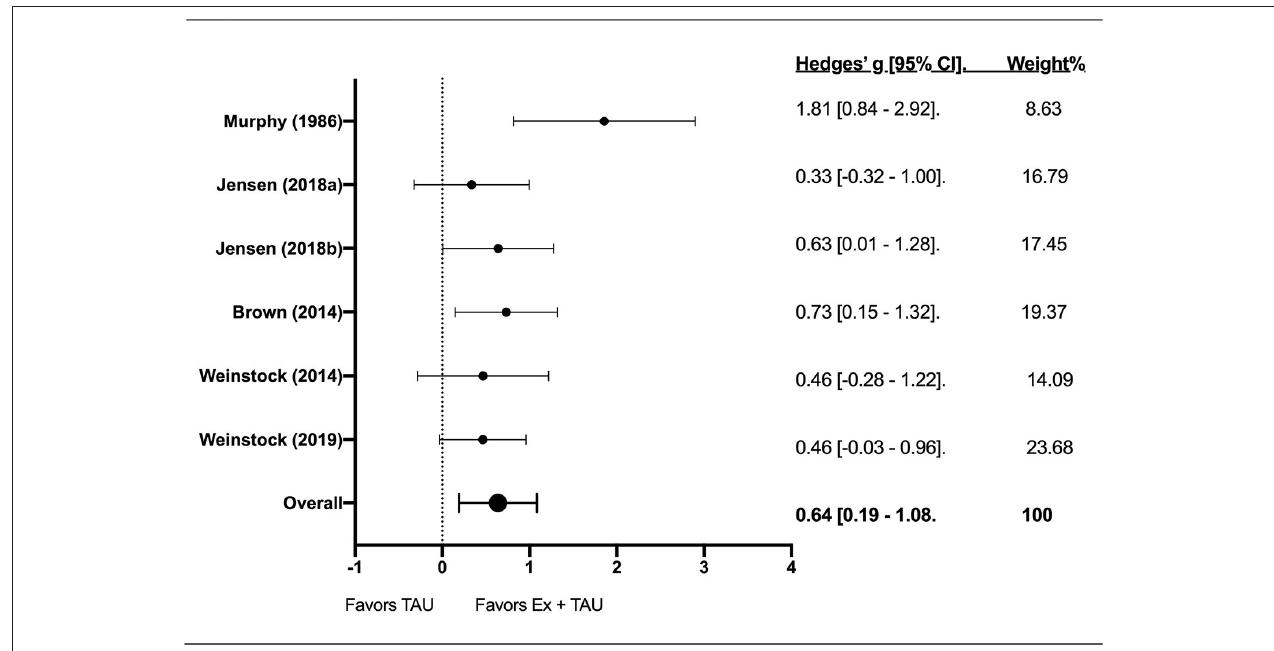
FIGURE 4 | The forest plot about the effect of exercise on physical